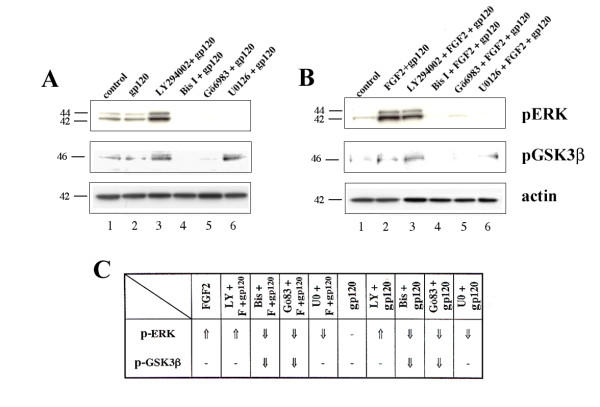
Effects of FGF2, gp120, and inhibitors on ERK and GSK3β phosphorylation (A, B) Western blots showing ERK and GSK3β phosphorylation with (A) gp120 alone (lane 2), and with inhibitors (lanes 3–6), (B) FGF2 and gp120 (lane 2), and FGF2 with inhibitors and gp120 (lanes 3–6). (C) Table summarizing data from western blots (A and B) showing changes in phosphorylation of ERK and GSK3β. ⇑ Indicates and increase, ⇓ indicates a decrease, – indicates no change.